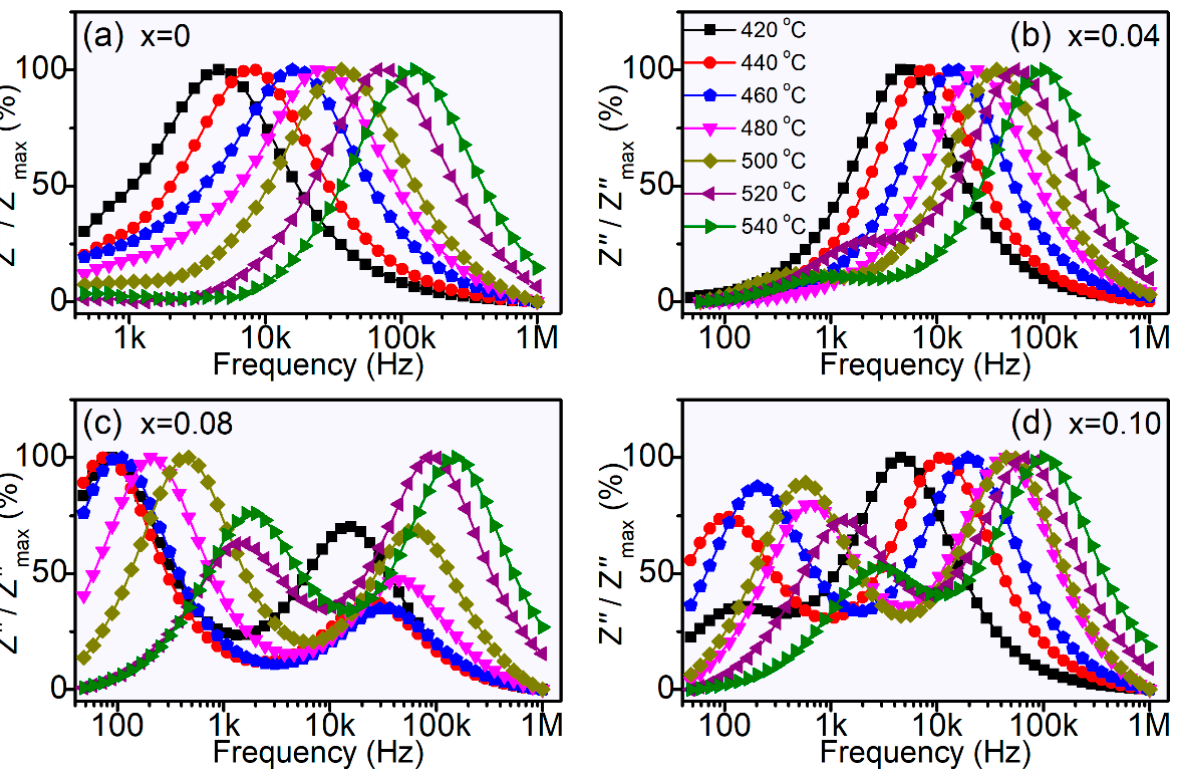
Figure 9. Frequency/temperature-dependent normalized imaginary parts of impedances for KNNS x - BNN ceramics with ( a ) x = 0, ( b ) x = 0.04, ( c ) x = 0.08 and ( d ) x = 0.10 measured at high temperature.